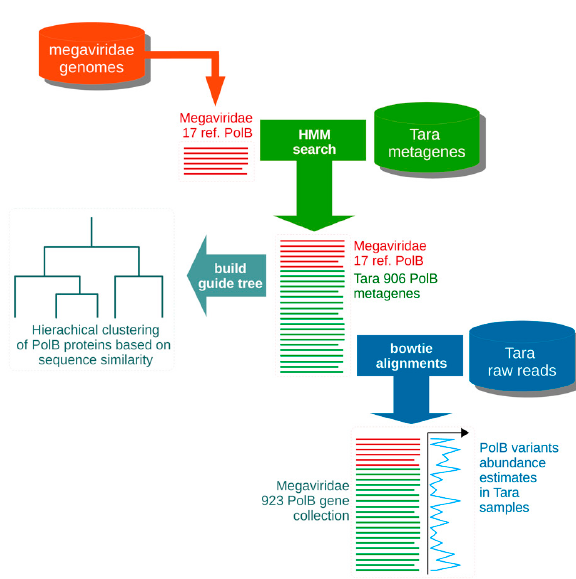
Figure 1. Schematic diagram of the building of the Megaviridae polB collection. This figure shows how the input data (reference Megaviridae genomes, Tara Oceans metagenes, and Tara Oceans raw reads) were used to produce a Megaviridae guide tree and a collection of 923 Megaviridae polB gene sequences.